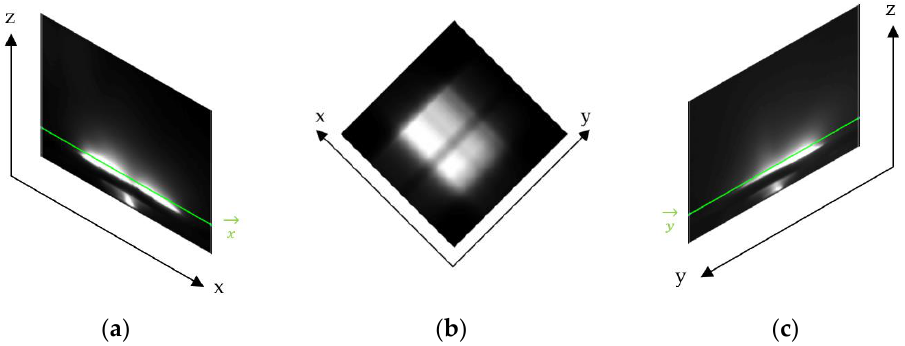
Figure 9. Graphical principle of cross-sectional image calculation from the two viewing directions: ( a ) left observation; ( b ) calculated cross-sectional image; ( c ) right observation.